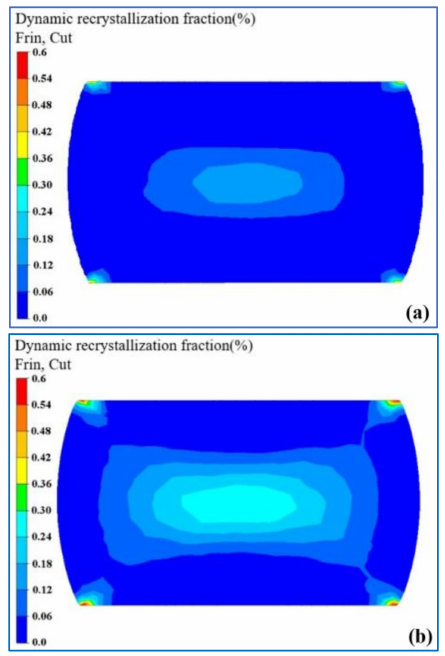
Figure 8. Comparison between the simulation results and experimental results: ( a ) simulation result . ε = 0.01 s − 1 and reduction rate of 40%; ( b ) simulation result with T = 500 ◦ C, with T = 300 ◦ C, . ε = 0.01 s − 1 and reduction rate of